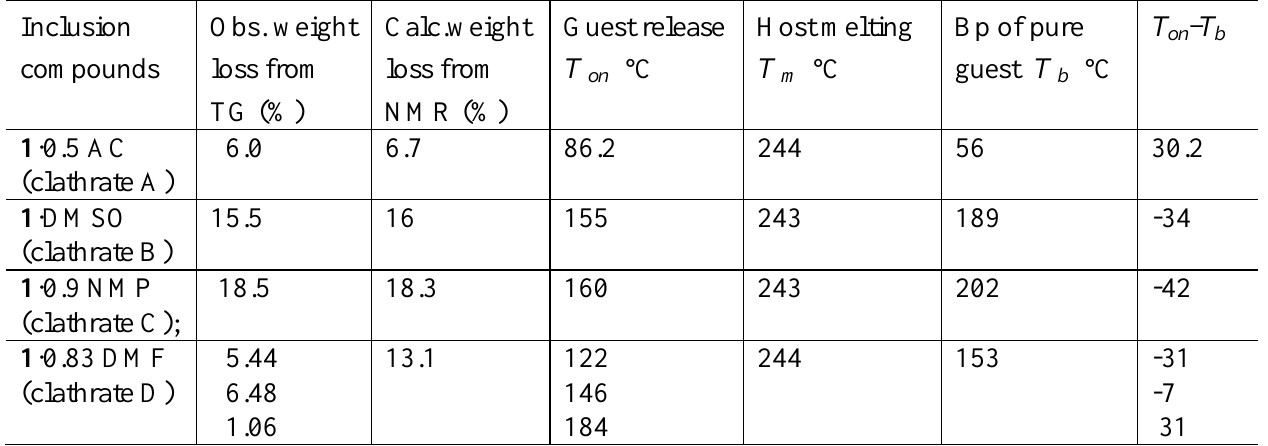
Table 3 . Thermal analysis result for the inclusion